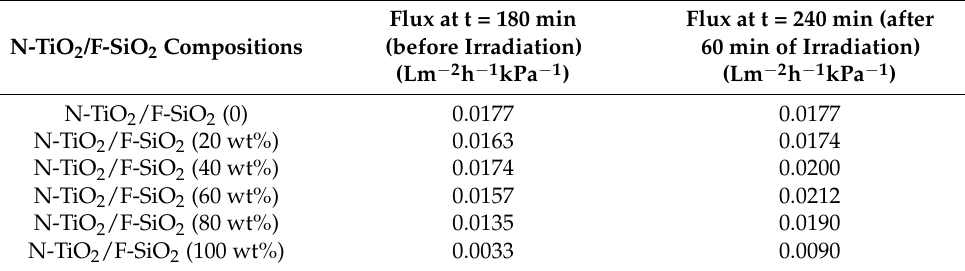
Table 2. The values of the flux of the water-rich permeate through the membranes coated with N- TiO 2 /F-SiO 2 with varied compositions after 60 min of irradiation with visible light ( I ≈ 198 mW cm − 2